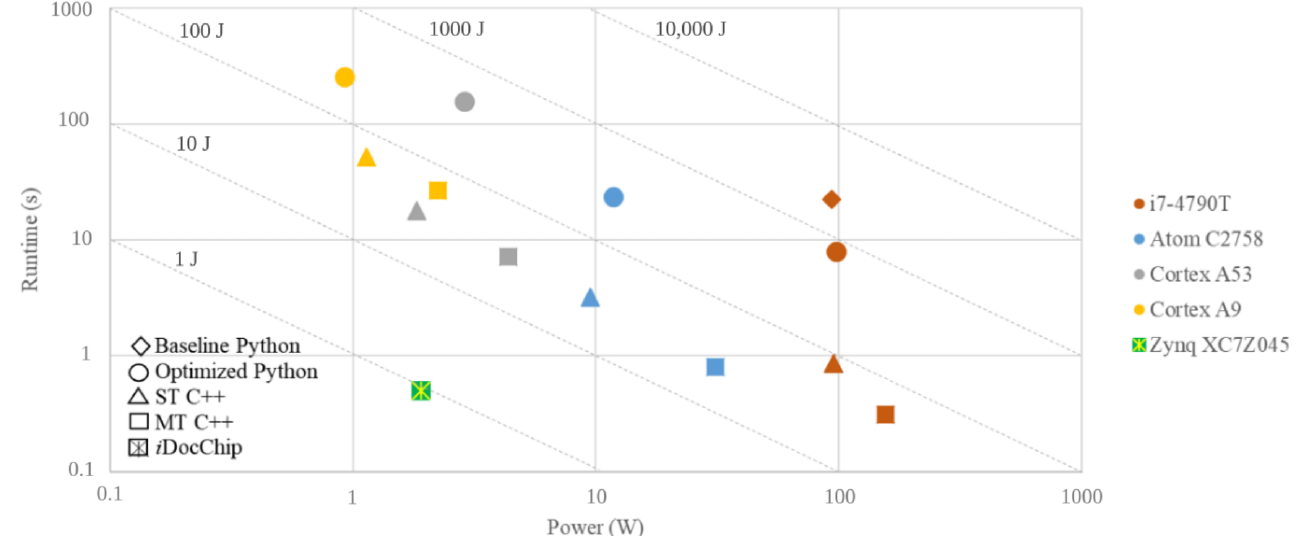
Figure 27. Power vs. runtime comparisons of the reference anyOCR and the optimized i DocChip algorithm on different platforms. Runtime is given per image. Single-threaded and multi-threaded implementations are represented as ST and MT . The grid lines show energy consumption in Joules